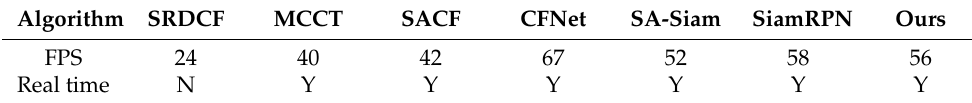
Table 5. The tracking speeds of the different object tracking algorithms in the testing sequences. Algorithm